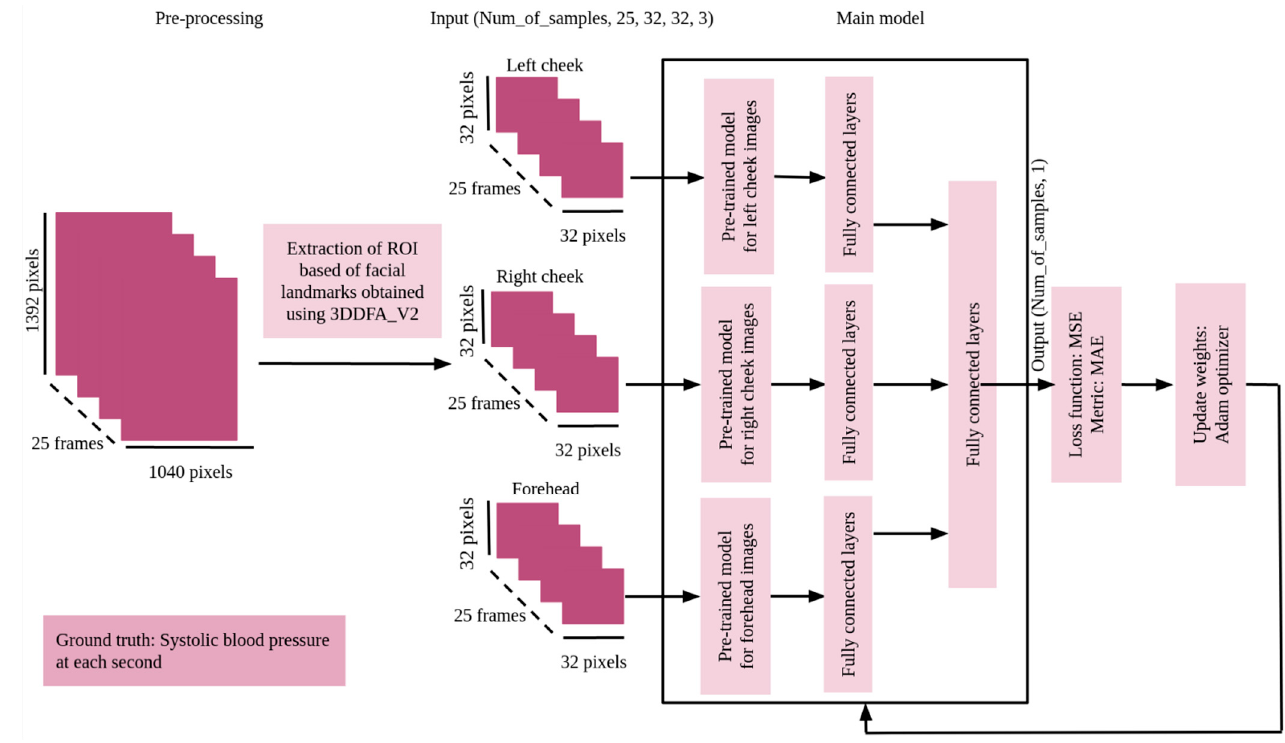
Figure 3. General scheme of the process of choosing CNN models.